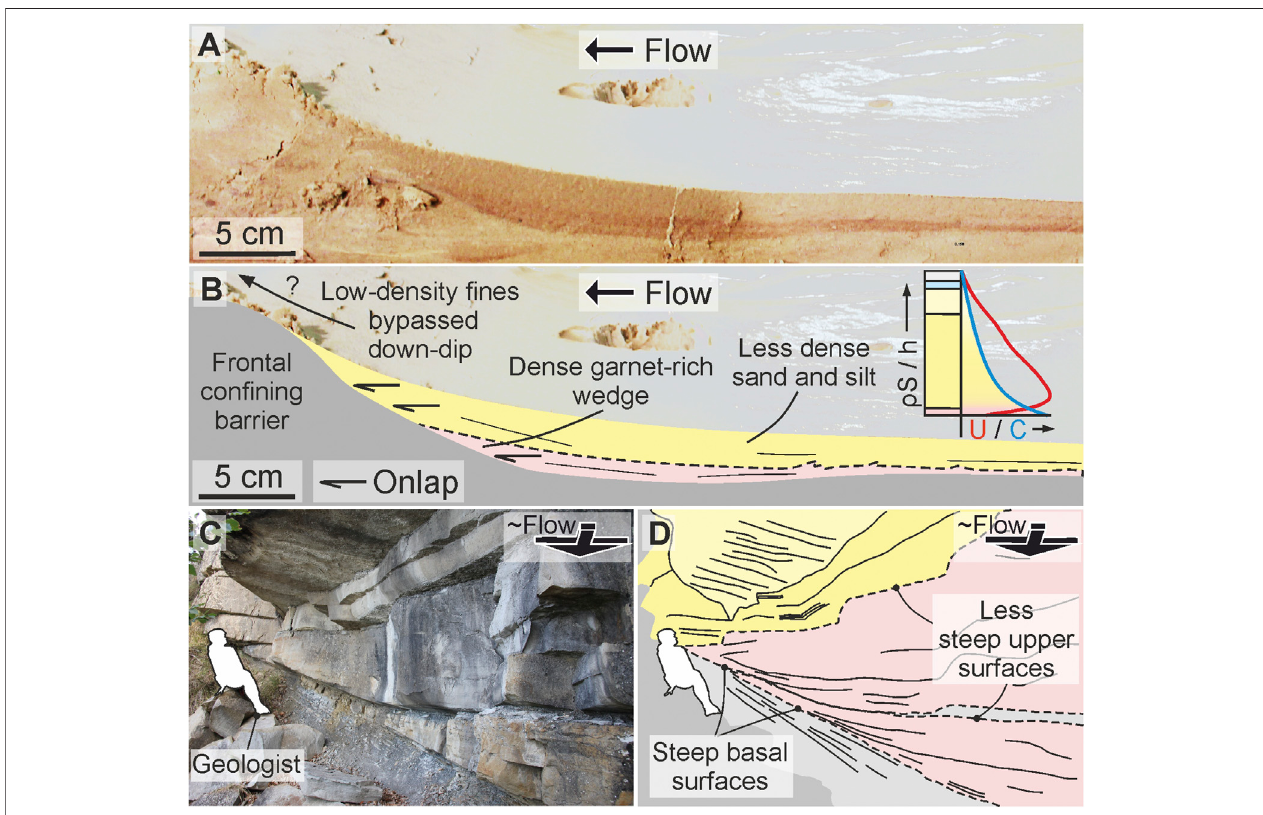
FIGURE 13 | (A) Uninterpreted and (B) interpreted cross-section photographs from the upstream side of the frontally con fi ning run. This section is taken ∼ 20 cm off-axis.Theimageshowsonlapofaredgarnet-richlayerandlayeronlapofamoresand-siltdominatedlayer.Aschematicconcentration-velocitypro fi leisalsoindicated on (B) based on the densities of the sediment that comprises the fl ow. (C) Uninterpreted and (D) interpreted fi eld expression of the onlap geometries seen on A and B. The red shading highlights the wedged onlapping fl ows. Outcrop in D is mirrored from actual outcrop (Col du Fa, 44 ° 0 ′ 33.84 ″ N/6 ° 43 ′ 5.52 ″ E).